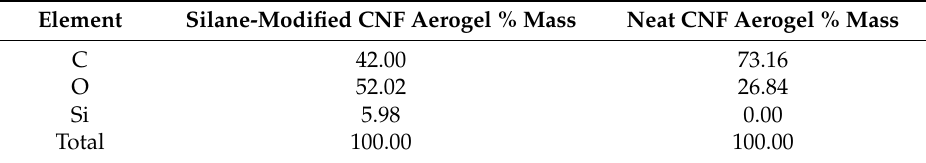
Table 1. Elemental composition of the silane-modified CNF aerogels.